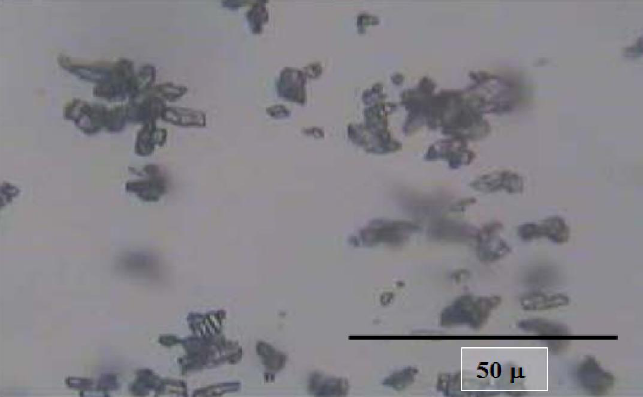
Figure 2. SEM image of old polymorph of desvenlafaxine